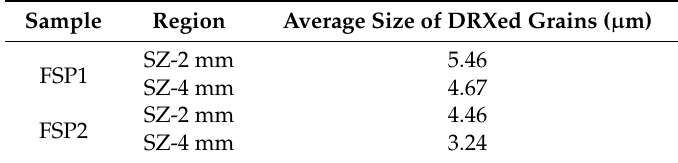
Figure 5. Inverse pole figure maps of an as-cast Mg-6Sn sample and the SZ-2 mm and SZ-4 mm regions in FSP Mg-6Sn samples obtained by EBSD: ( a ) as-cast Mg-6Sn sample, ( b ) SZ-2 mm region of the FSP1 sample, ( c ) SZ-2 mm region of the FSP2 sample, ( d ) SZ-4 mm region of the FSP1 sample, and ( e ) SZ-4 mm region of the FSP2 sample. Table 2. Average size of the DRXed grains in the SZ-2 mm and SZ-4 mm regions of Mg-6Sn samples created with FSP.